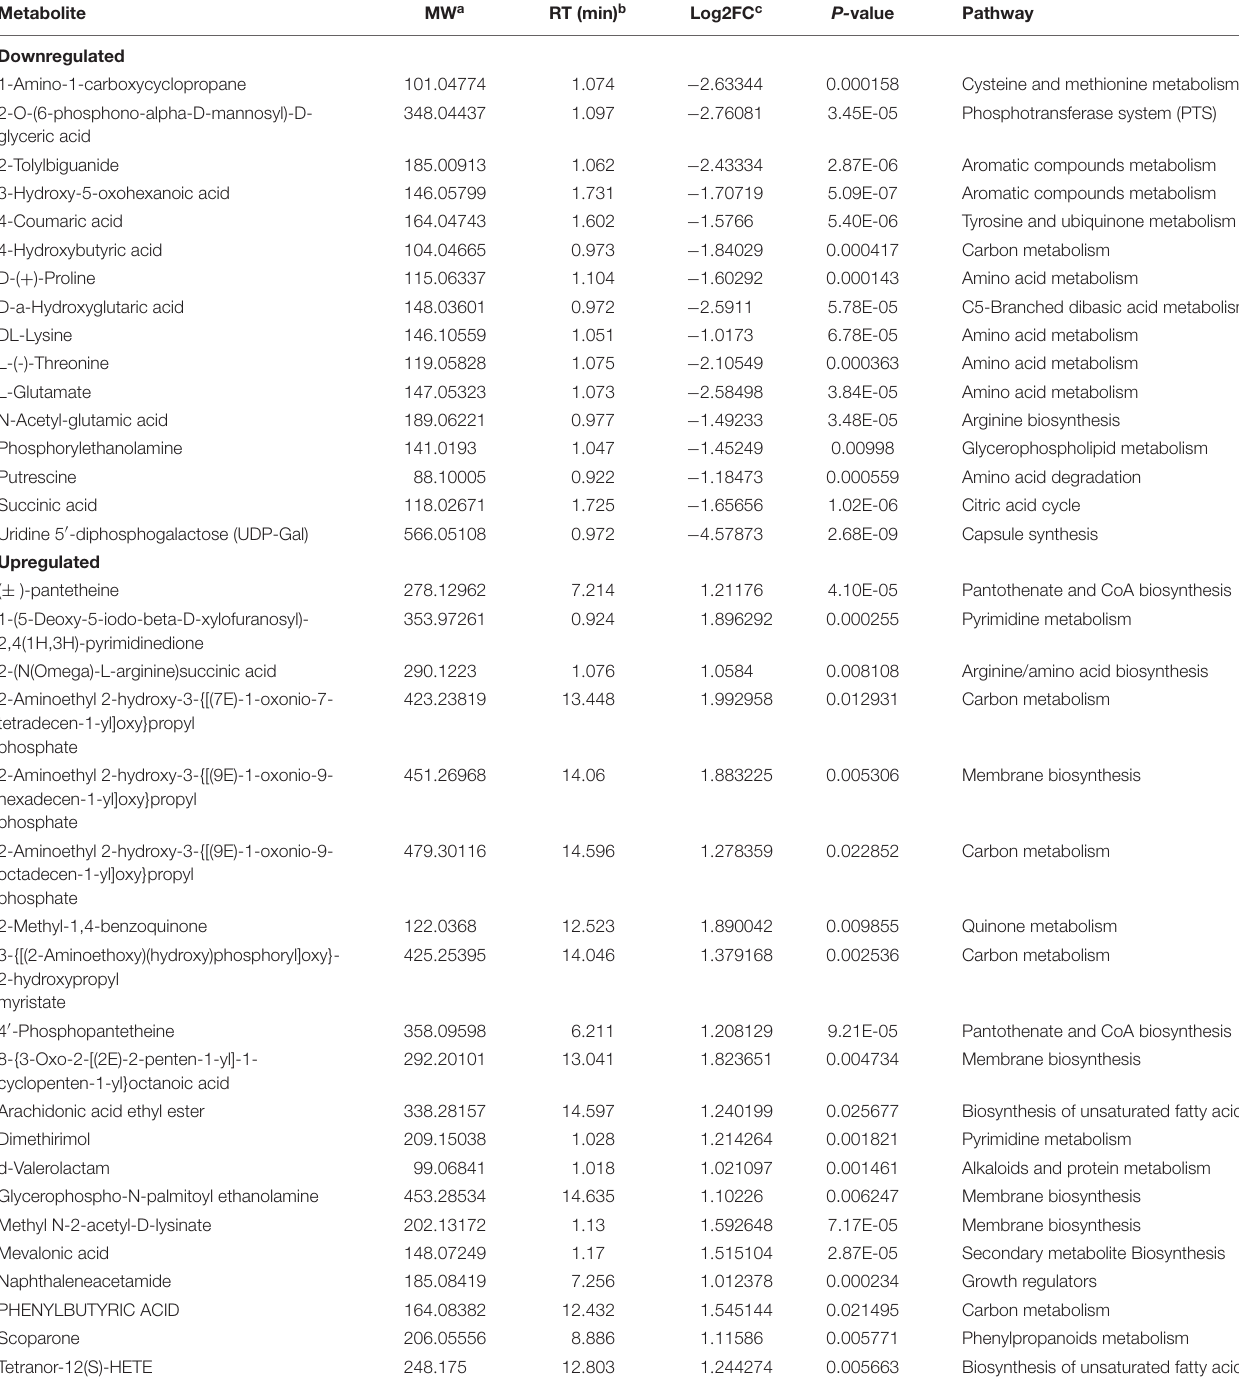
TABLE 2 | Differentially produced metabolites in (cid:49) kguR mutant compared to the wild type. Metabolite MW a RT (min) b Log2FC c P- value